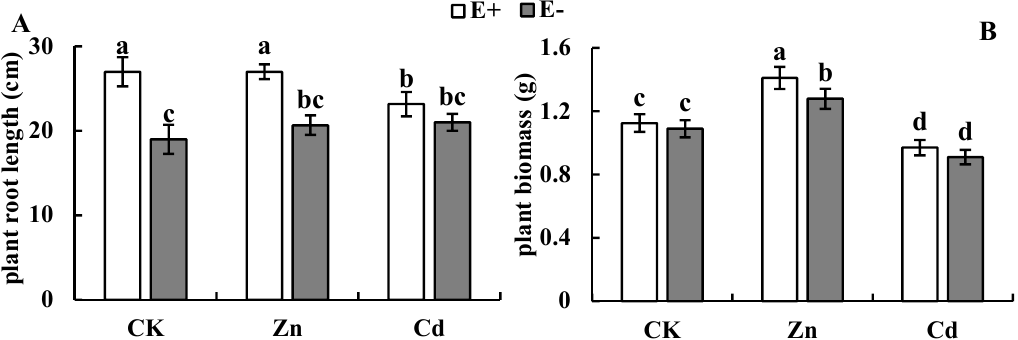
Figure 3. Effects of Epichloë endophyte and Cd 2+ and Zn 2+ treatments on plant root length ( A ) and biomass ( B ) of F. sinensis . Note: Different lowercase letters indicate significant differences between treatments ( p < 0.05).